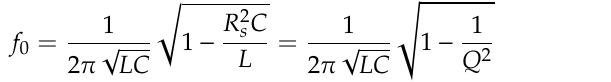
Figure 5. FEM simulation of inductance, L , under external force and deformation.